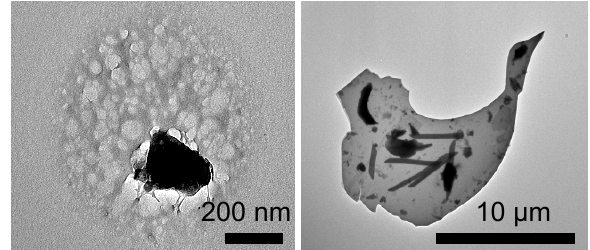
Figure 11. TEM images of volcanic ash mixed with secondary material in the 0.2–0.5 µm Fig. 11. TEM images of volcanic ash mixed with secondary mate- rial in the 0.2–0.5µm sample (left image) and volcanic ash in the sample (left image) and volcanic ash in the >11 µm sample (right image) collected > 11µm sample (right image) collected between 11:37 and 15:05 between 11:37 and 15:05 local summer time during the episode on 25 May. local summer time during the episode on 25